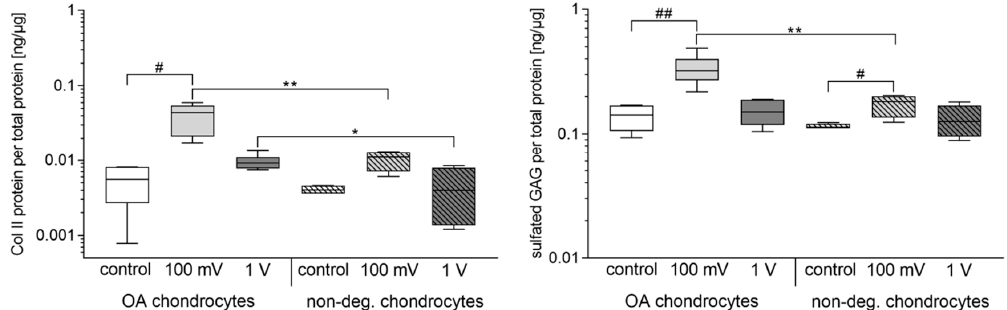
Figure 6. Release of collagen (Col) II and glycosaminoglycans (GAG) in human chondrocytes after electrical stimulation with 100 mV and 1 V at 1 kHz. Chondrocytes derived from electrical stimulation with 100 mV and 1 V at 1 kHz. Chondrocytes derived from non-degenerative ( n = 4) or osteoarthritic (OA) cartilage ( n = 6) were seeded on collagen scaffolds and stimulated over a